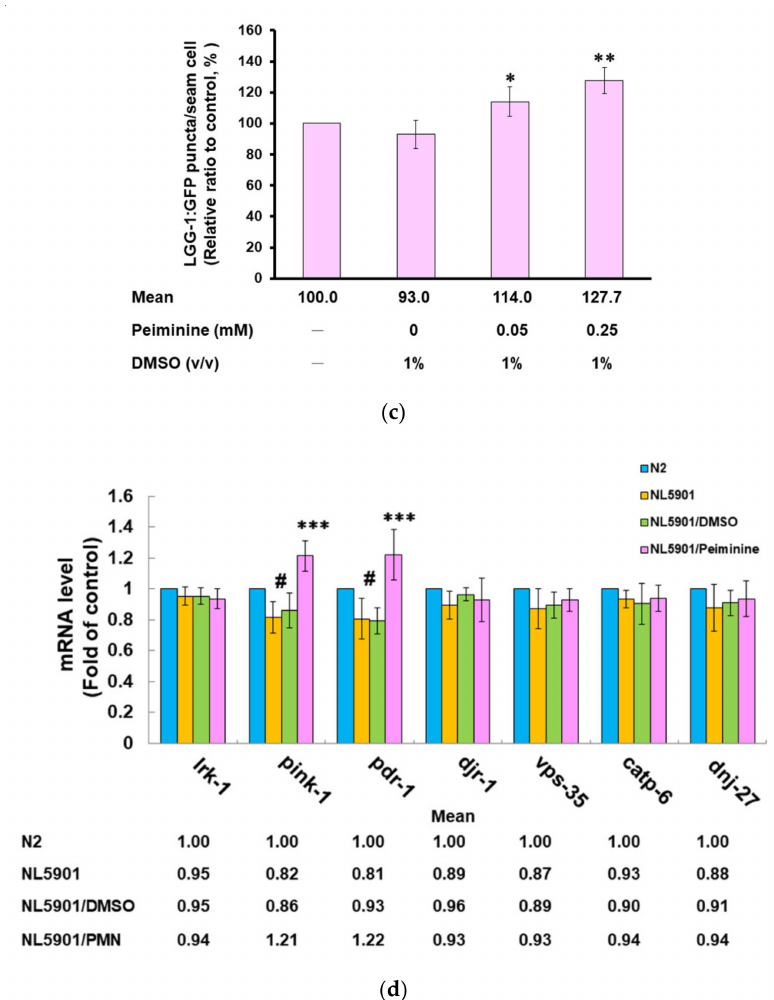
Figure 6. Treatment with peiminine (PMN) enhanced proteasome activity, autophagy, and pdr-1 expression in NL5901 transgenic worms. ( a ) L1 stage NL5901 worms were cultured on OP50/NGM plates with or without PMN for 1 day. Worms were then transferred to OP50/NGM/FUDR plates with or without PMN and cultured for 3 days for analysis. The worm extracts of each group were tested for proteasome activity under the same amount of total protein. # Indicates a significant difference between N2 and NL5901 worms ( # p < 0.01). * Indicates a significant difference between the PMN-treated group and the PMN-untreated group (* p < 0.05, ** p < 0.01). ( b ) L1 stage DA2123 worms were cultured on OP50/NGM plates with or without PMN for 1 day. Worms were then transferred to OP50/NGM/FUDR plates with or without PMN and cultured for 3 days for analysis. Representative images of the fluorescence distribution of positive puncta in the seam cells of each group of worm. Scale bar = 10 µ m. ( c ) The number of positive puncta in the seam cells of DA2123 worms was calculated. At least 20 worms were calculated in each group, and at least 20 seam cells were calculated for each worm. * Indicates a significant difference between the PMN-treated group and the PMN-untreated group (* p < 0.05, ** p < 0.01). ( d ) The expression levels of PD-related genes in N2 and PMN-untreated or treated NL5901 worms were quantified by qPCR. # Indicates a significant difference between N2 and NL5901 worms ( # p < 0.05). * Indicates a significant difference between the PMN-treated group and the untreated group (*** p <